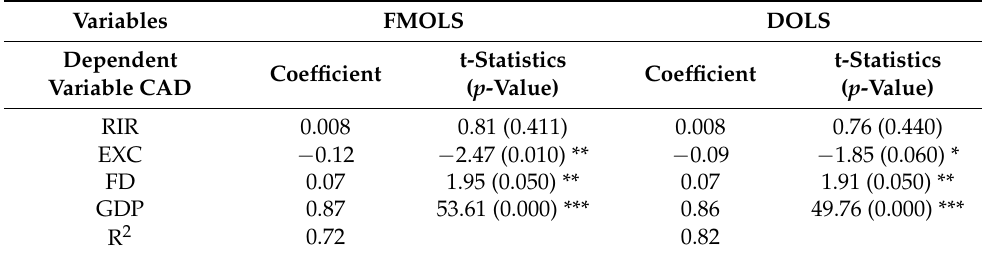
Table 14. Findings of FMOLS and DOLS for